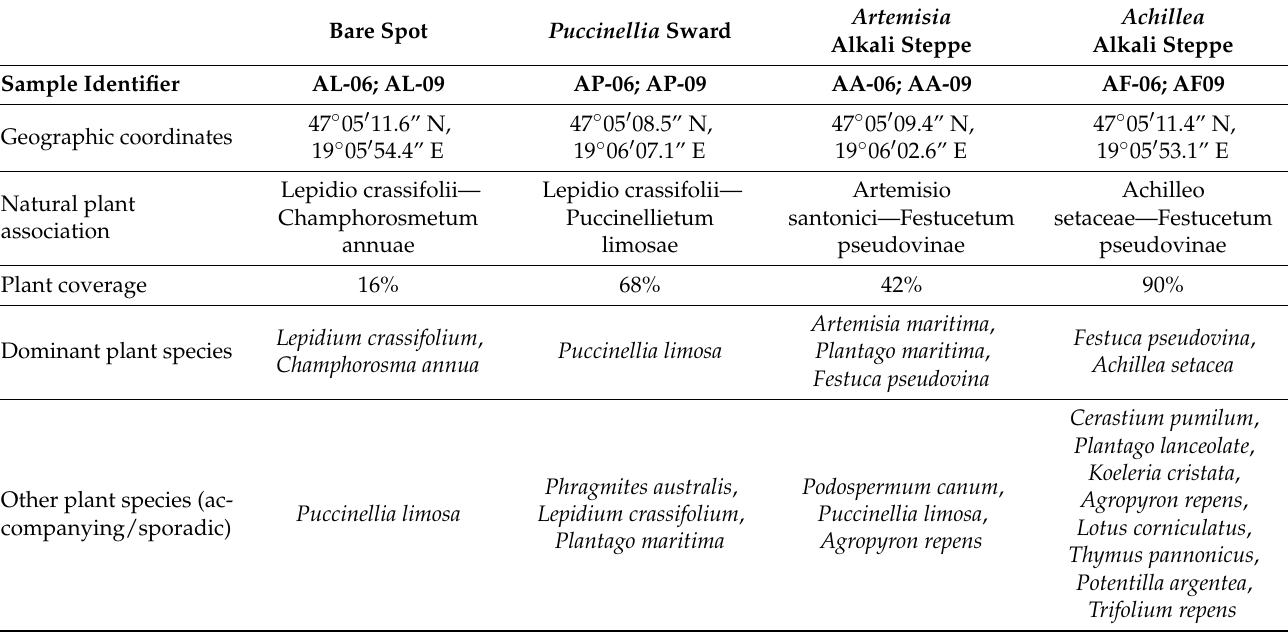
Table 1. Sampling sites, geographical coordinates and vegetation